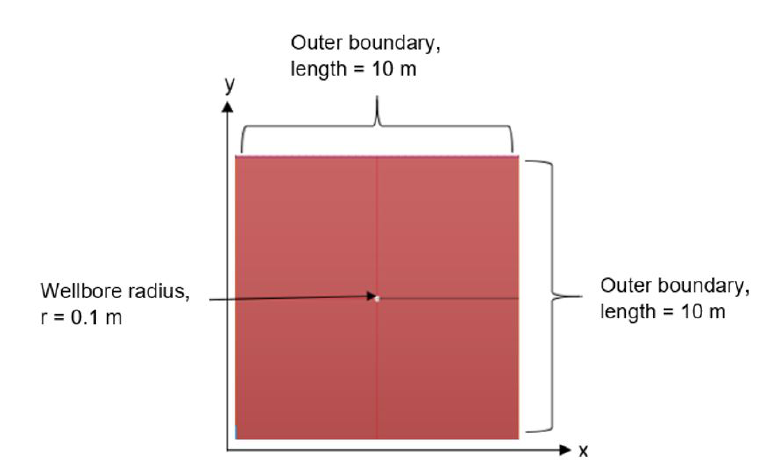
Figure 2. A CAD model depicting the top view of a wellbore in 2D; length = 10 m, width = 10 m, and wellbore radius = 0.1 m.